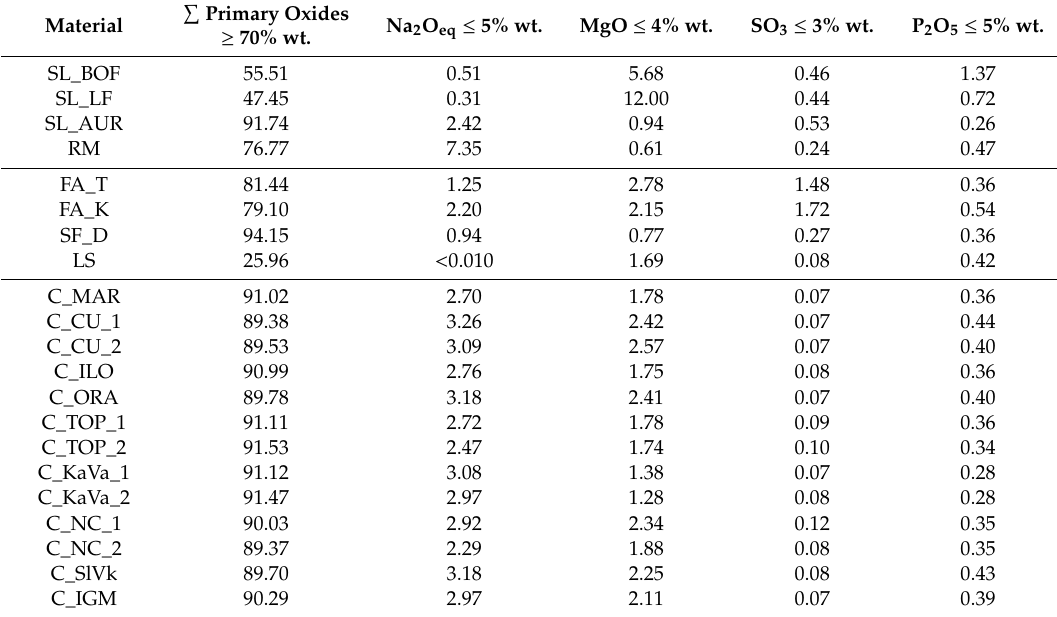
Table 1. Chemical and physical characteristics of collected raw materials with limitations according to EN 450:1 [20].